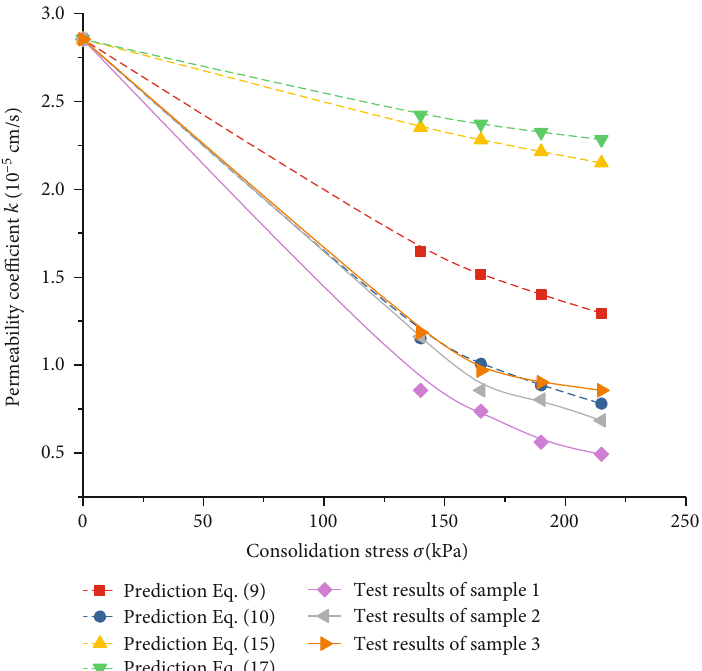
Figure 21: The comparison of the measured and predicted values of one-dimensional consolidation permeability coe ffi cient of normally consolidated